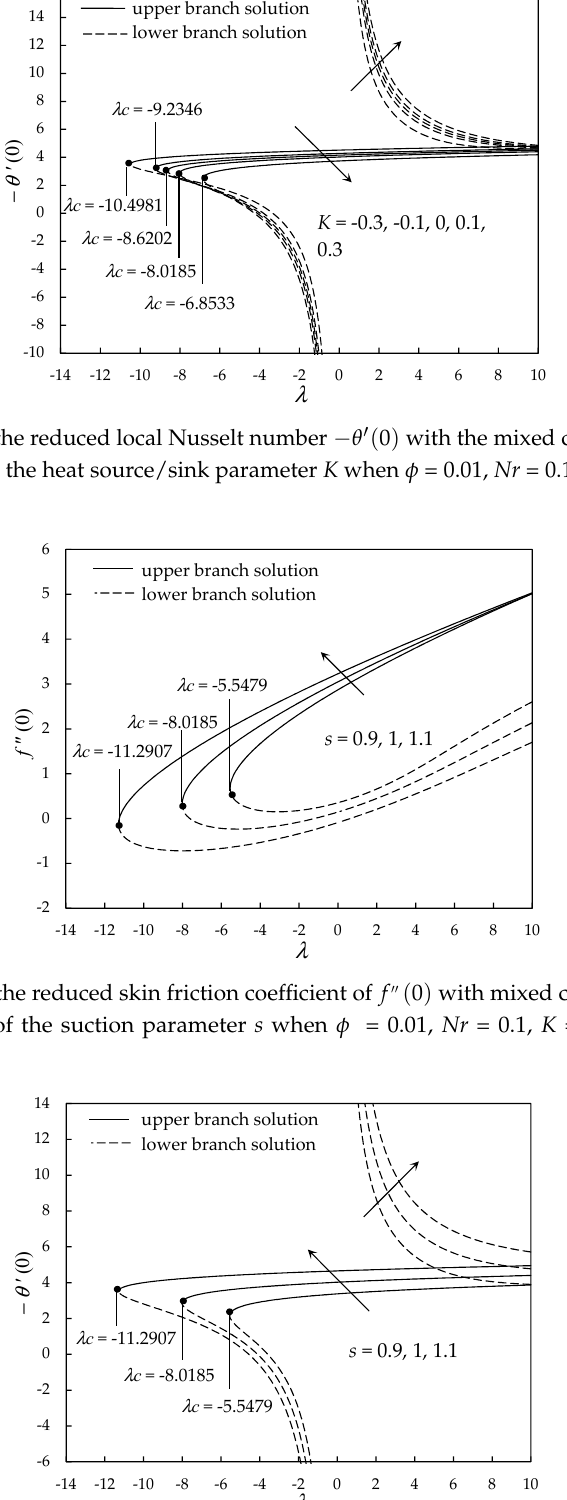
Figure 8. Variation of the reduced skin friction coefficient of 𝑓 (cid:4593)(cid:4593) (0) with mixed convection parameter 𝜆 for various values of the suction parameter s when 𝜙 = 0.01, Nr = 0.1, K = 0.1 and c = − 1 for Cu-water nanofluid.